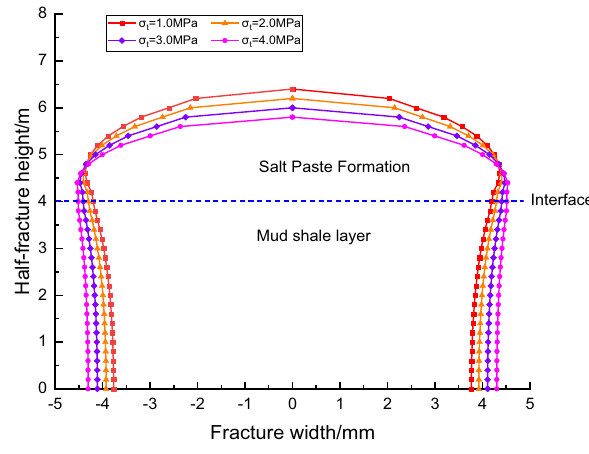
Fig. 20 Fracture morphology under different tensile strength